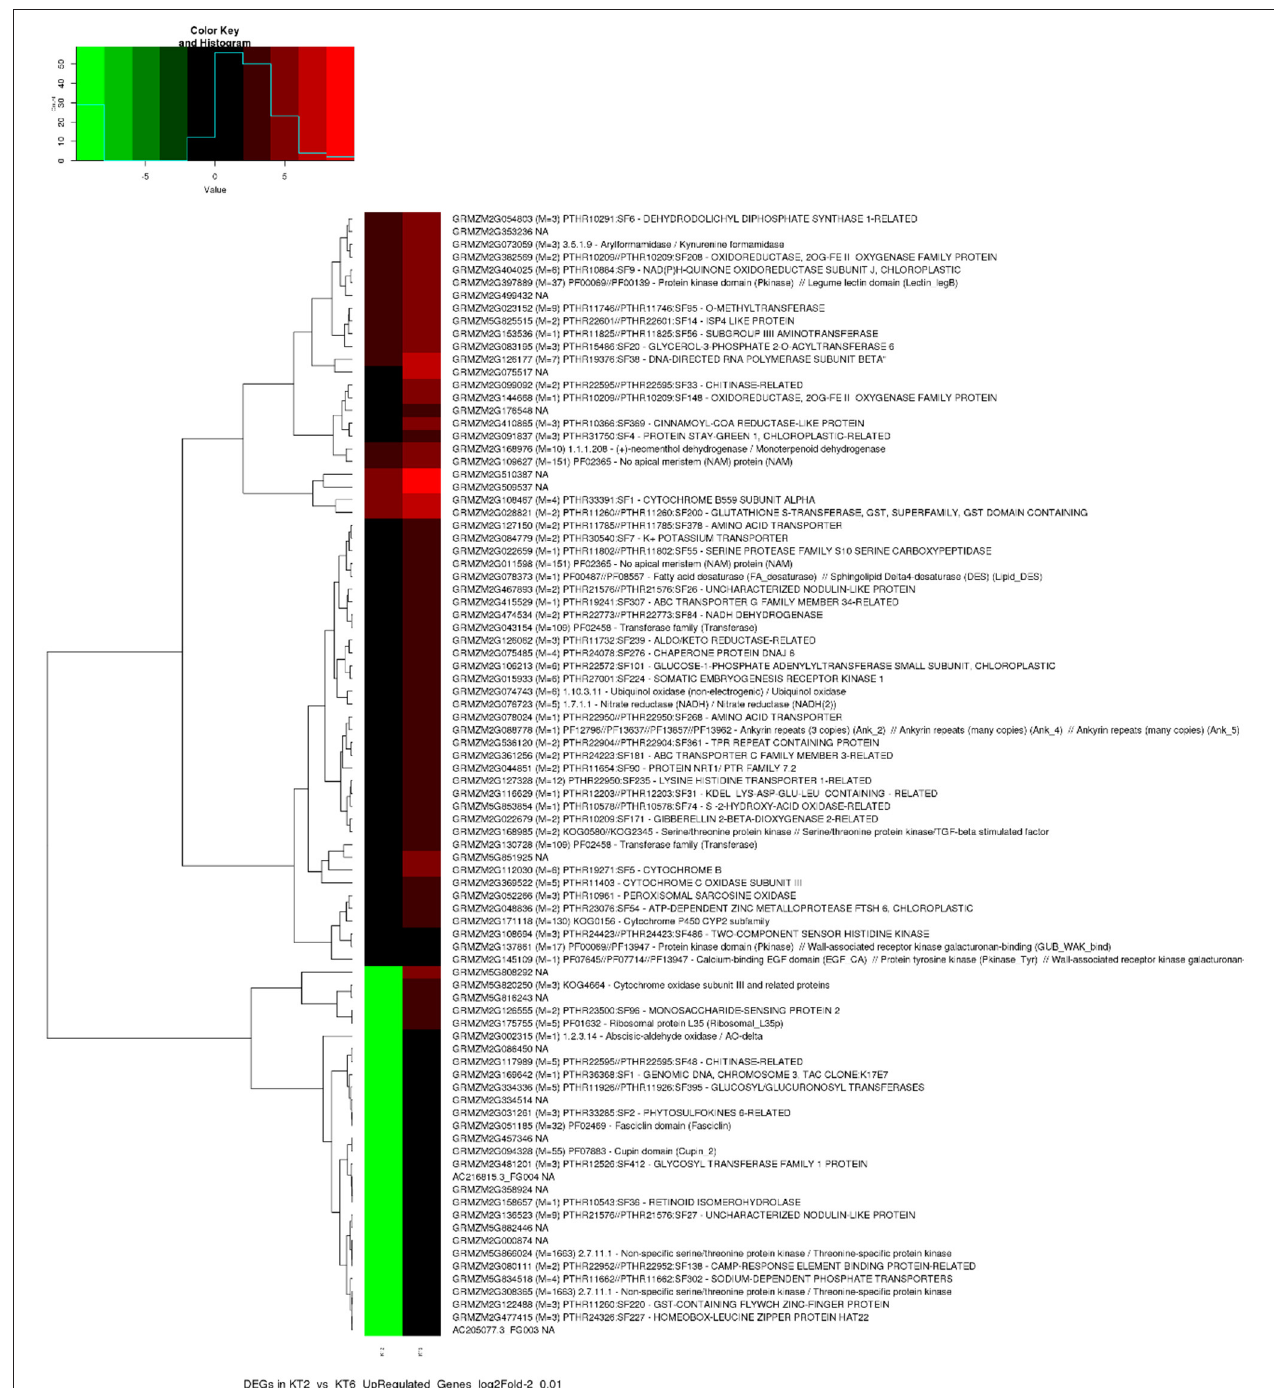
FIGURE 1 | KT2 vs. KT6 heat map of top 50% highly variable upregulated genes.